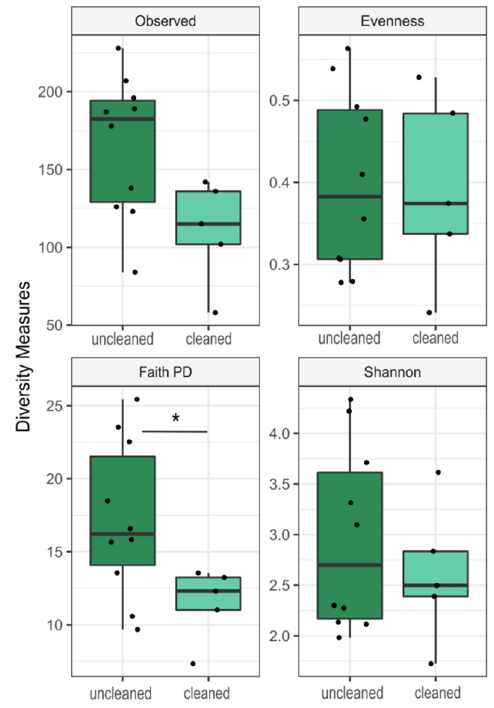
Figure 4. Comparison of alpha diversity measures between uncleaned and cleaned microscope oculars. Differences are shown by four indices (observed, Pielou’s evenness, Faith’s phylogenetic diversity and Shannon diversity). Points represent individual samples. Displayed are the median, the 25% and 75% quartiles and outliers. Whiskers represent the lowest and highest microbial counts within the 1.5-fold of the interquartile range (IQR) (the 25% and 75% quartile). Asterisks mark a statistically significant difference between cleaned and uncleaned oculars (* p -adjust = 0.04), based on Kruskal-Wallis Test with Benjamini-Hochberg multiple test correction.